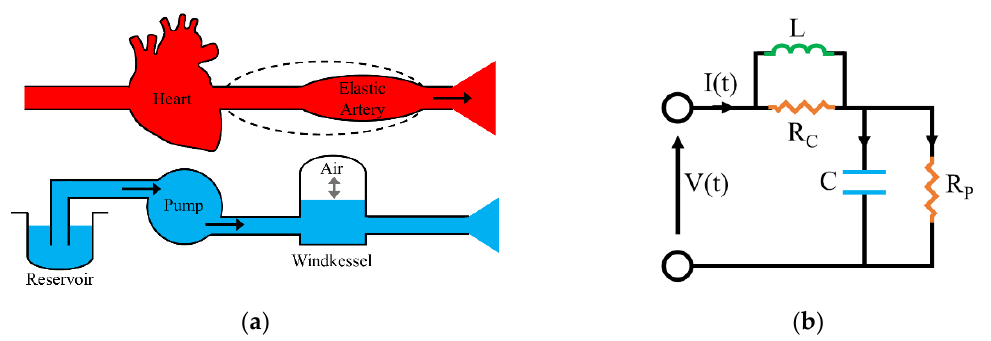
Figure 2. Windkessel model: ( a ) schematic diagram of the windkessel effect, redrawn based on https://commons.wikimedia.org/wiki/File:Windkessel_effect.svg; ( b ) 4-element windkessel model through fluid–electric analogy, V ( t ) : input voltage, I ( t ) : input current, R : peripheral resistance, R C : characteristic resistance, L : inertance, C : compliance.